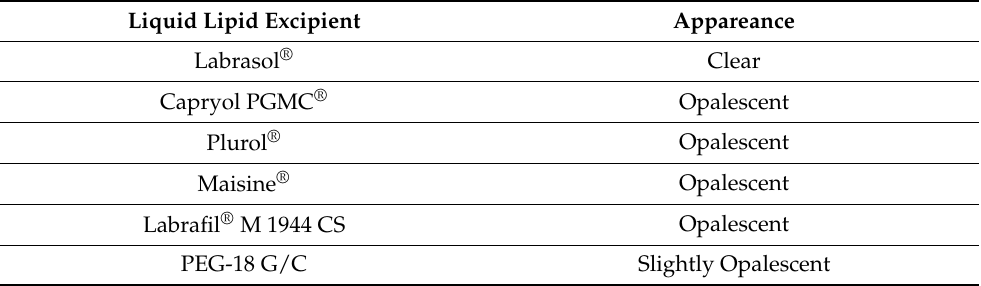
Table 4. Visual evaluation of QRC dissolution in selected liquid